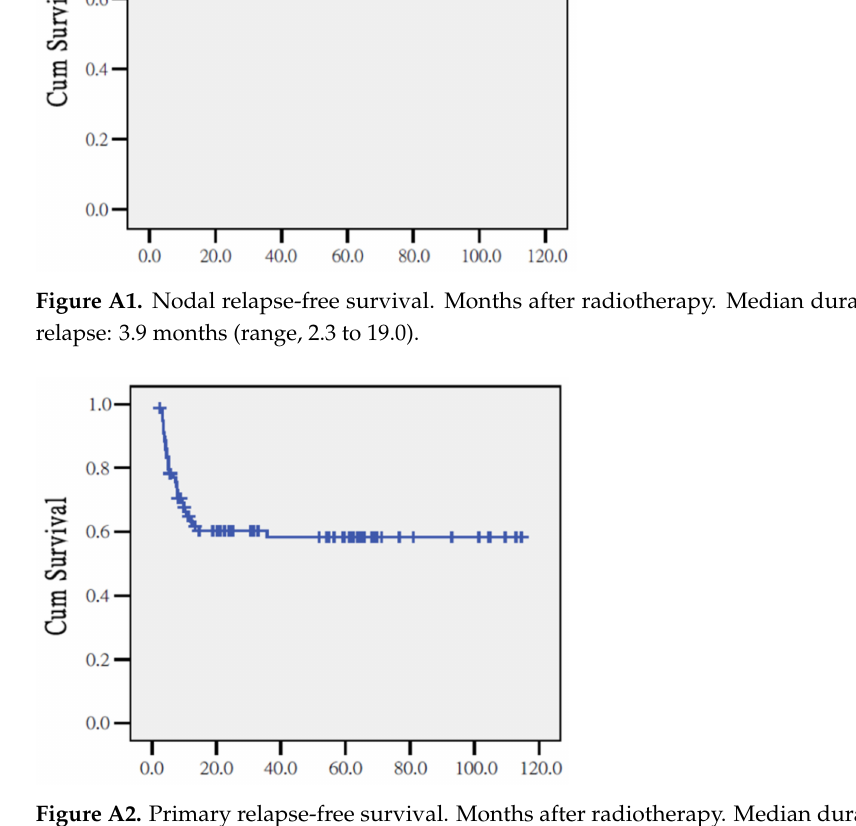
Figure A2. Primary relapse-free survival. Months after radiotherapy. Median duration of primary relapse: 5.3 months (range, 2.3 to 35.7).